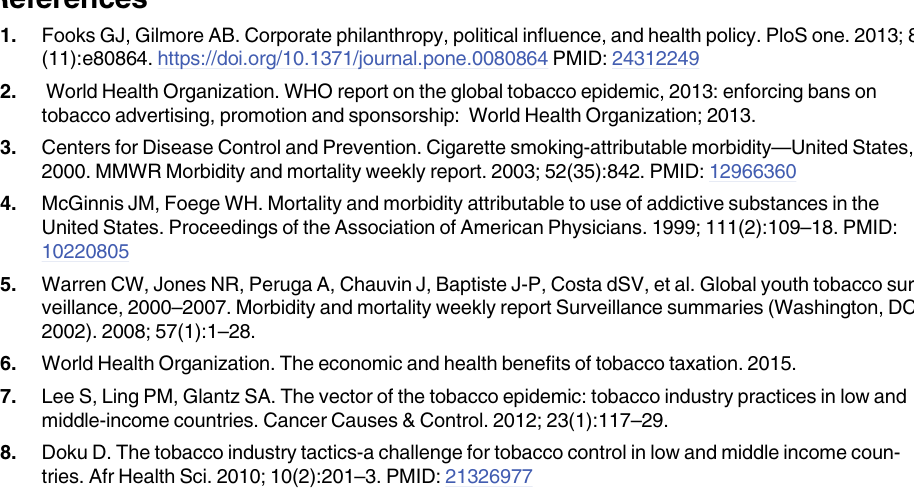
S1 Table. Predictors of smoking: Domains and Cronbach’s Alphas. S2 Table. Pretested English